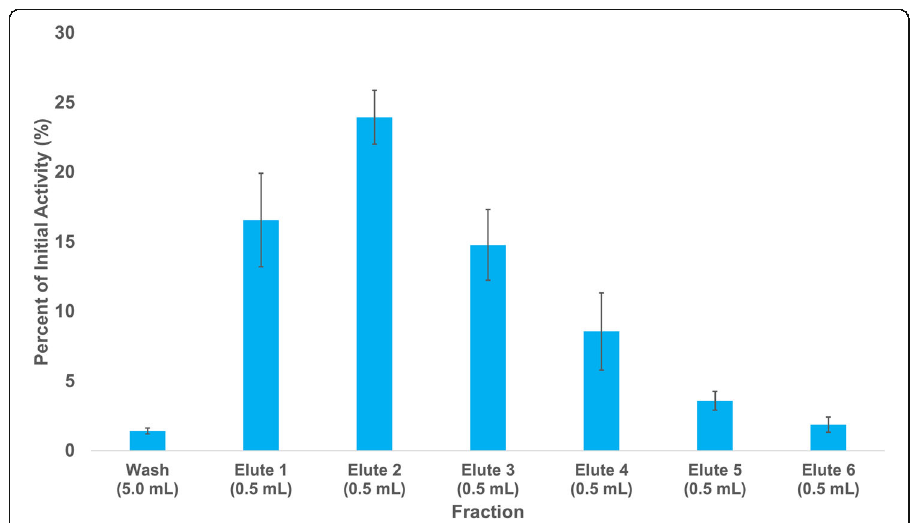
Fig. 5 Average elution profile for 228 Th/ 212 Pb separation from Pb resin using NH 4 OAc (1 M, pH 7) ( n = 4)